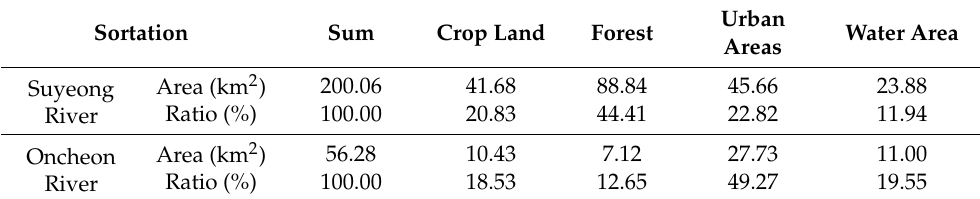
Figure 1. Study area (Coordinates: 35.18892898003925, 129.11526723161828). Table 1. Land use and cover structures in the study river basin (using GIS data). Table 1. Land use and cover structures in the study river basin (using GIS